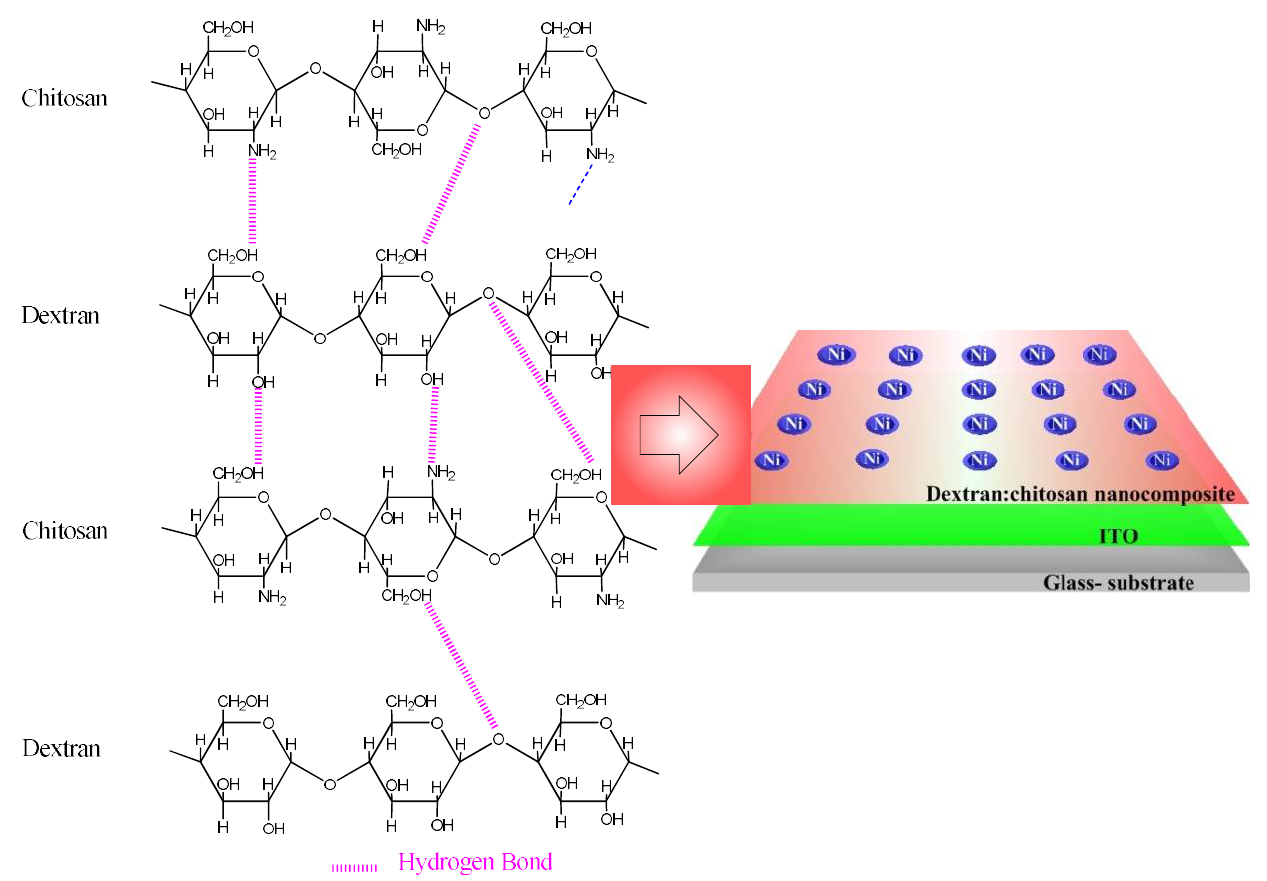
Figure 6. Schematic diagram of molecular structure of chitosan and dextran; interaction between chitosan and dextran; configuration of ITO/dextran–chitosan/Ni biomemristor.